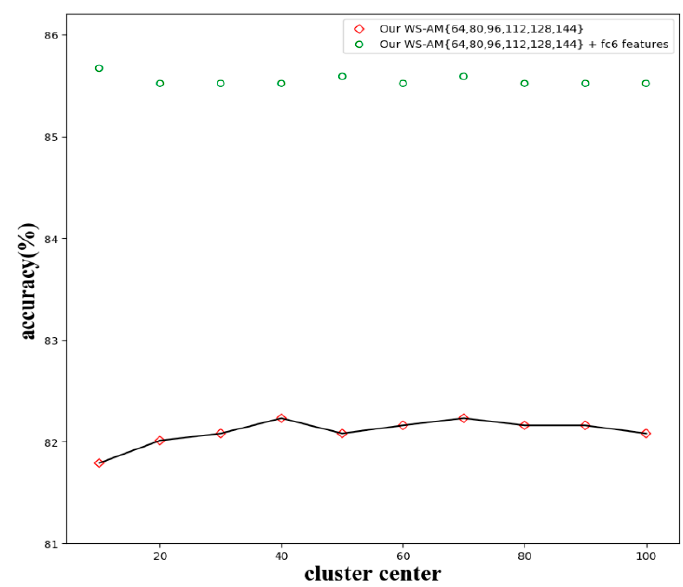
Figure 11. The recognition accuracies of a different number of cluster centers on MIT indoor 67 dataset. Table 7. Accuracy with L2-normalization or without L2-normalization on MIT Indoor 67 dataset. V GR V { 112 , 128 , 144 }